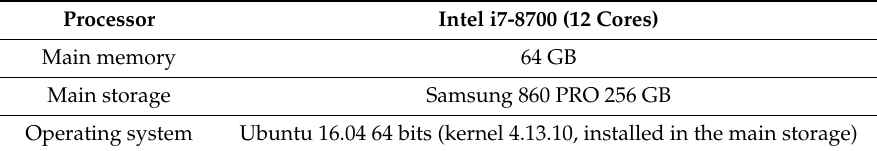
Table 1. Experimental environment.